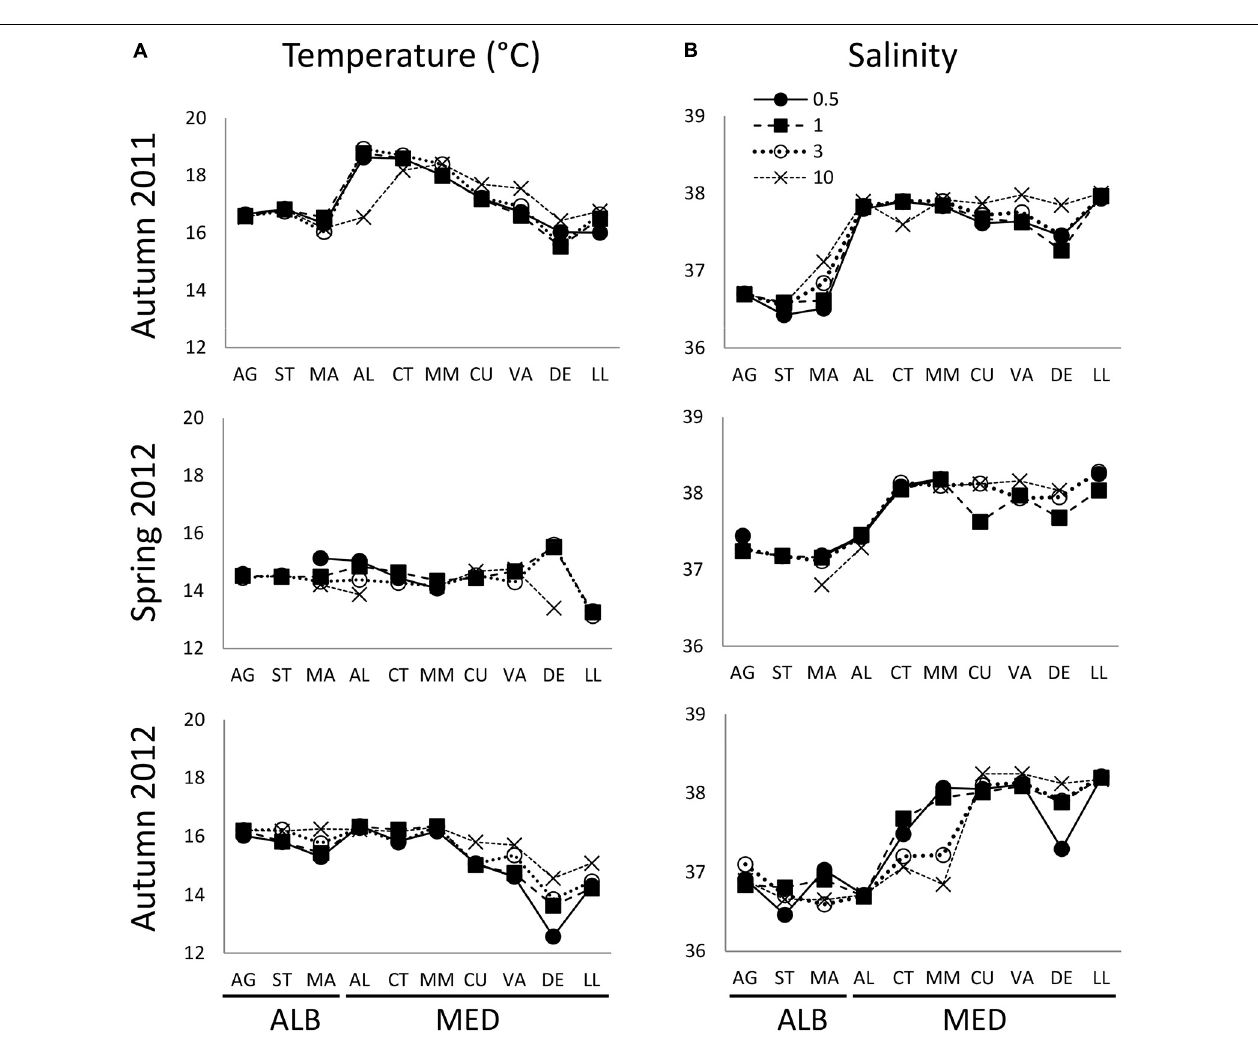
FIGURE 2 | Average sea surface (0–5 m) (A) temperature ( ◦ C) and (B) salinity distribution from AG to LL at 0.5, 1, 3, and 10 km distance from the coast in autumn 2011, spring 2012, and autumn 2012. Transect codes as in Figure 1 .